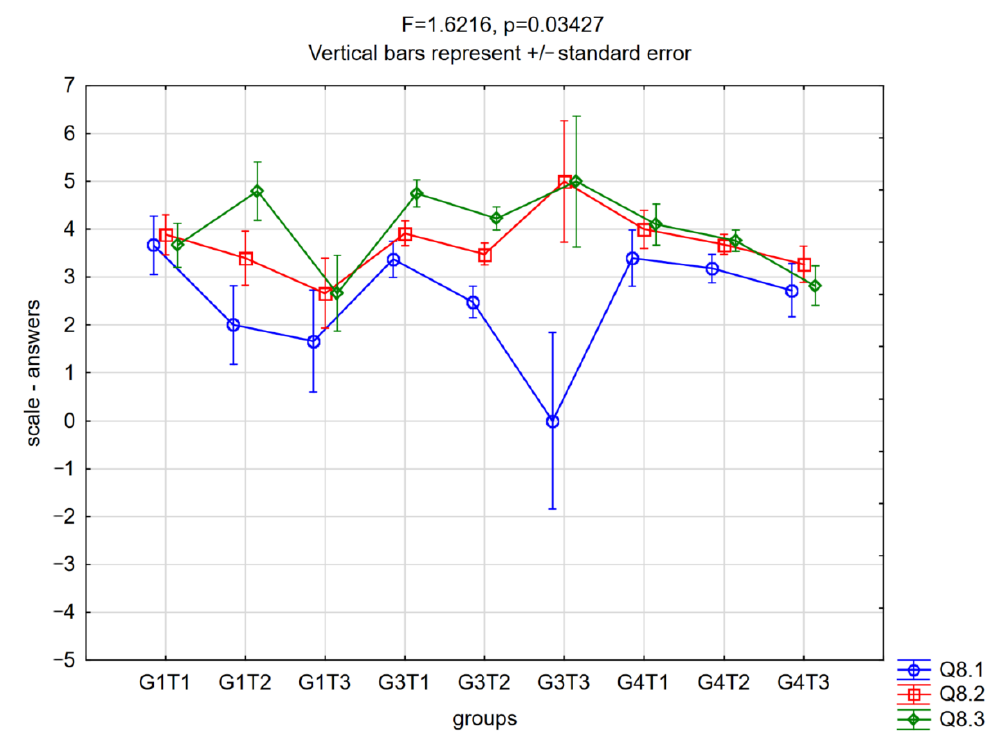
Figure 3. Average trust assessment values (scale from − 5 to 5) at three stages of participation by organization type. ANOVA at a significance level of 0.05.